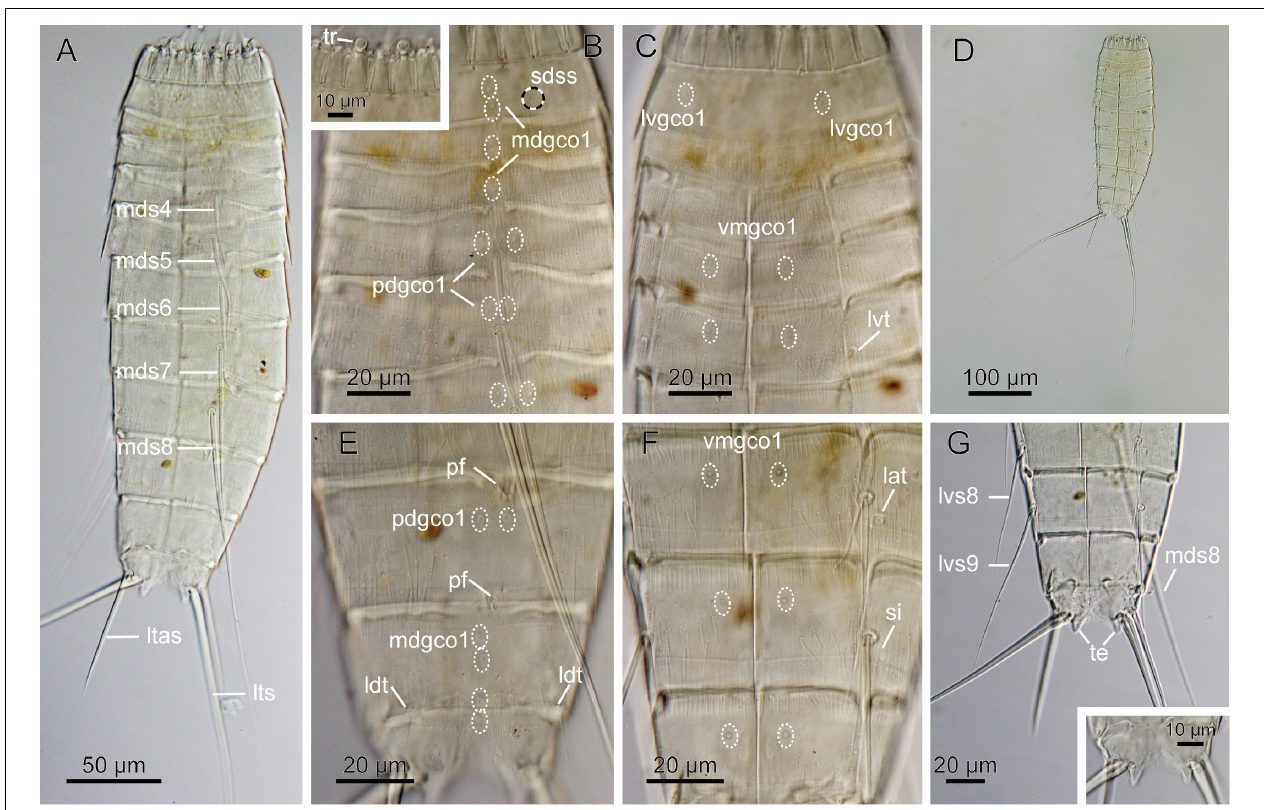
FIGURE 8 | Light micrographs showing overview and details of female Echinoderes sp. 2 (NHMD-872654) collected at station 7. (A) Dorsal overview. (B) Segments 1 to 6, dorsal view, with close-up showing trichoscalids. (C) Segments 1 to 5, ventral view. (D) Dorsal overview, showing full length of lateral terminal spines. (E) Segments 8 to 11, dorsal view. (F) Segments 8 to 10, ventral view. (G) Segments 8 to 11, ventral view, with close-up on segment 11 showing tergal extension. lat , lateral accessory tube; ldt , laterodorsal tube; ltas , lateral terminal accessory spine; lts , lateral terminal spine; lvgco1 , lateroventral glandular cell outlet type 1; lvs , lateroventral spine, followed by segment number; lvt , lateroventral tube; mdgco1 , glandular cell outlet type 1; mds , middorsal spine, followed by segment number; pdgco1 , paradorsal glandular cell outlet type 1; pf , papillary flap; sdss , subdorsal sensory spot; si , sieve plate; te , tergal extension; tr , trichoscalid; vmgco1 , ventromedial glandular cell outlet type